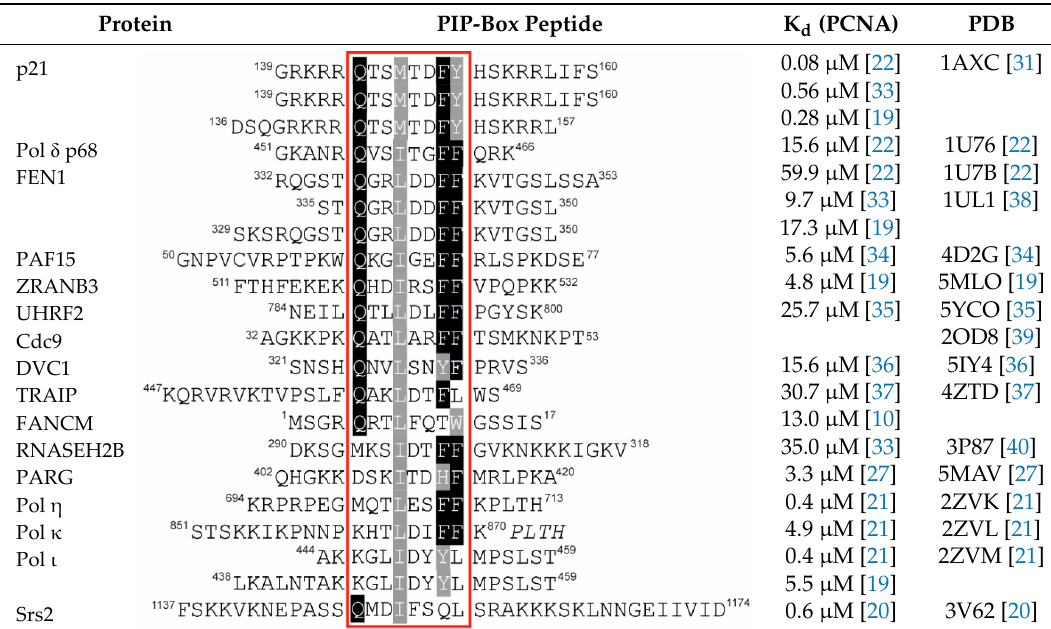
Table 1. Sequence alignment of PIP-boxes for which binding affinities and/or crystal structures with PCNA are available. Binding affinities are represented as dissociation constant (K d ). The values are not fully comparable due to variable methods and conditions in which they were obtained, as well as different peptide length/sequence. When available, more than one binding affinity from different publications is indicated. The following binding assays were employed: isothermal titration calorimetry (ITC) [10,19,22,27,33–37]; surface plasmon resonance (SPR) [21]; fluorescence polarization